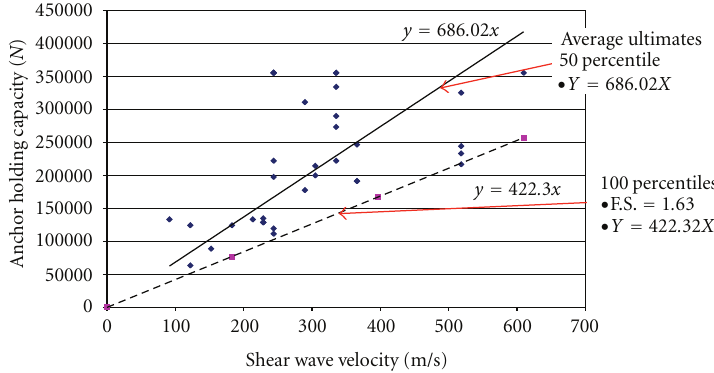
Figure 7: Anchor holding capacity versus shear wave velocity with 50 percentile and 100 percentile linear correlations.